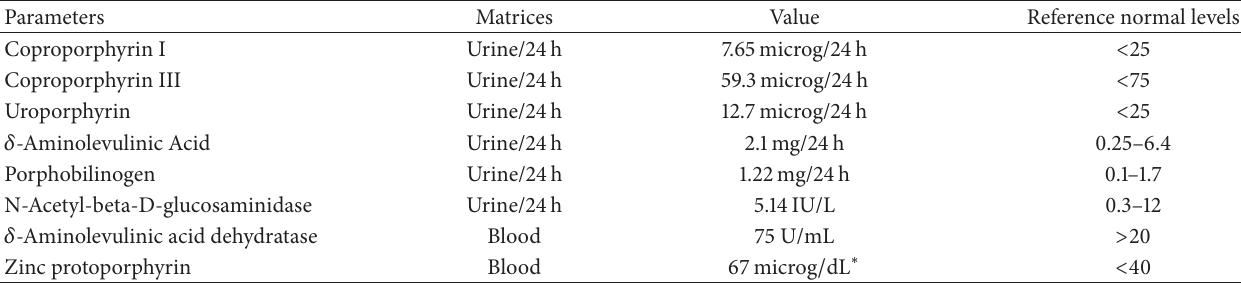
Table 2: Laboratory parameters evaluated for the clinical assessment of the patient on admission at Toxicology Unit of IRCCS Salvatore Maugeri